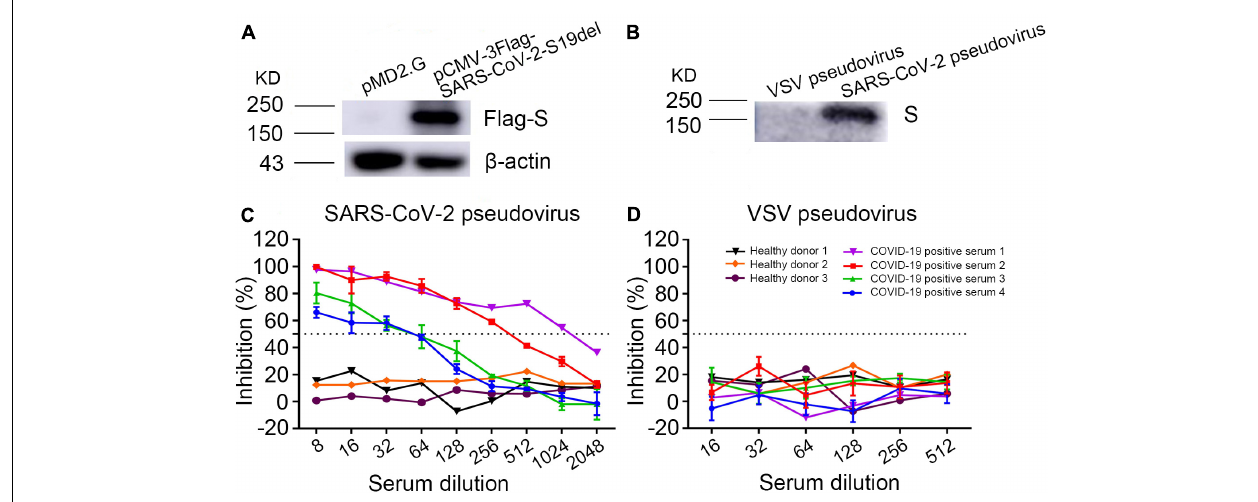
FIGURE 2 | Validation of the SARS-CoV-2 pseudovirus neutralizing assay. (A) Detection of SARS-CoV-2 spike protein expression in plasmid pCMV-3Flag-SARS-CoV-2-S19del transfected cell lysates by Western blot using anti-Flag antibody. Plasmid pMD2.G was used as the negative control. (B) Detection of SARS-CoV-2 spike protein expression in PEG 8000 concentrated pseudoviruses from cell culture supernatant with a serum of COVID-19 convalescent patient. VSV pseudovirus was used as the negative control. (C,D) Inhibition of SARS-CoV-2 pseudovirus or VSV pseudovirus using COVID-19 patients’ and healthy persons’